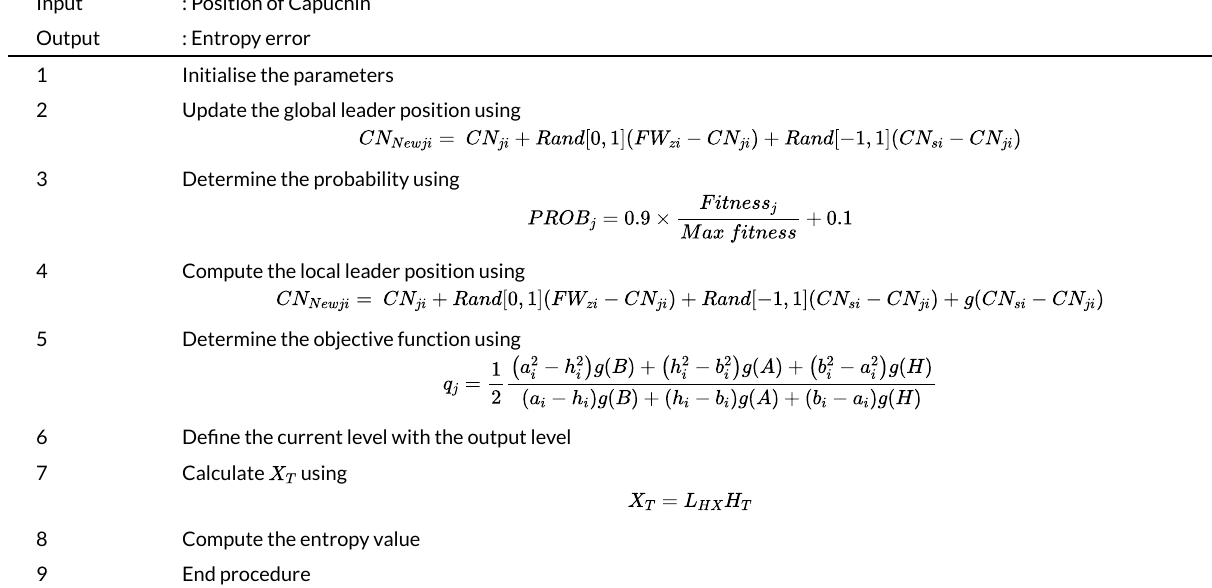
Algorithm 2. Task scheduling using MCS